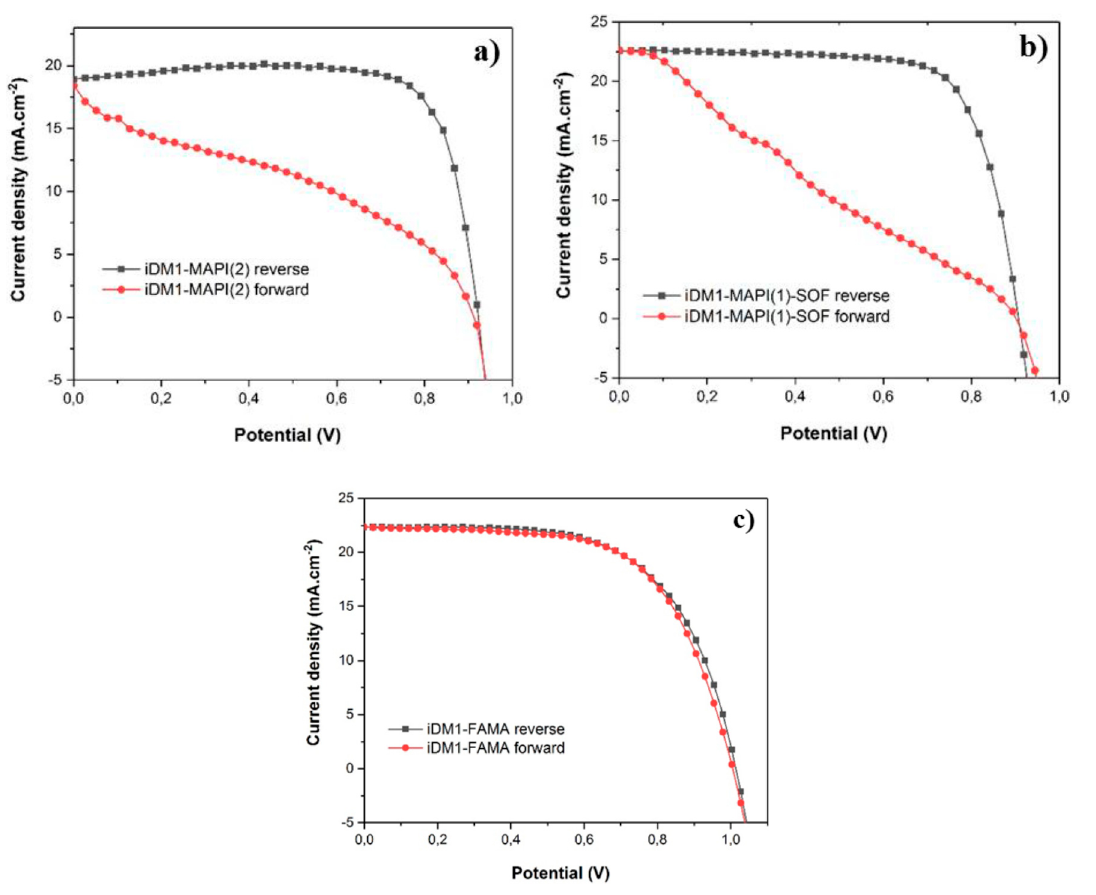
Figure 3. J–V curves of the best iDM1 based perovskite photovoltaics (PSCs) made from ( a ) MAPI(2) , ( b ) MAPI(1)-SOF and ( c ) FAMA perovskites. Table 1. Best and average (values given in parenthesis) photovoltaic parameters of iDM1 cells prepared with di ff erent perovskite (MAPI(2), MAPI(1)-SOF and FAMA). The performance of Spiro-OMeTAD based perovskite photovoltaics (PSCs) were taken from our previous report for comparison purpose.